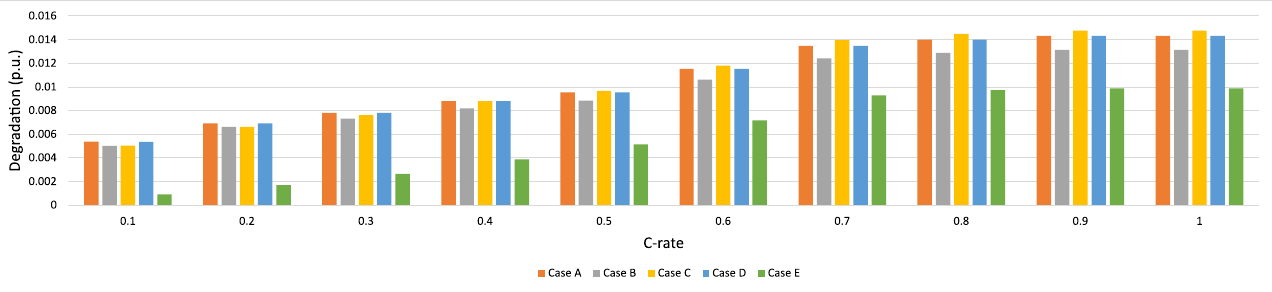
Figure 11. BESS Degradation results for each case